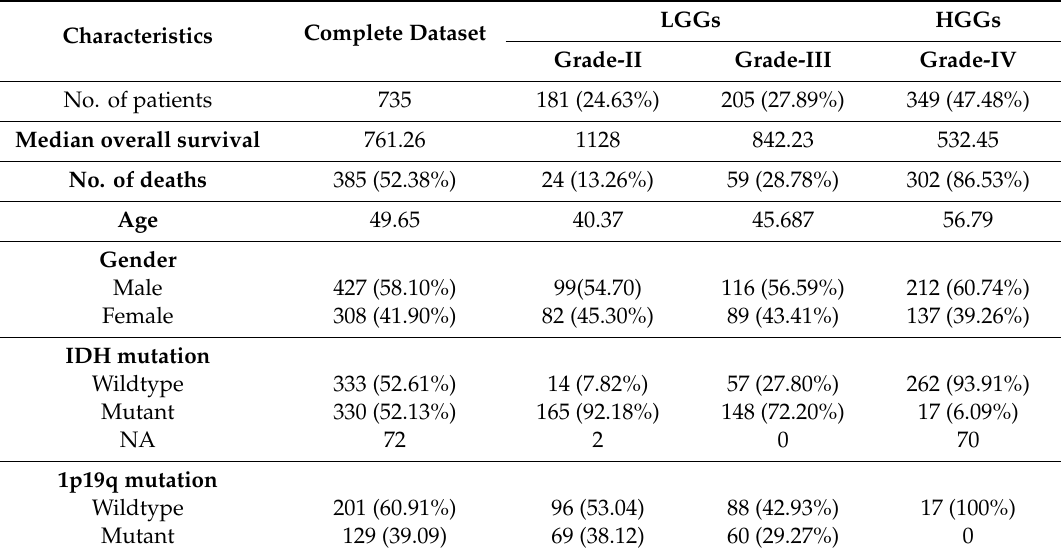
Table 1. Clinical and genomic profile of 735 glioma patients involved in the study.